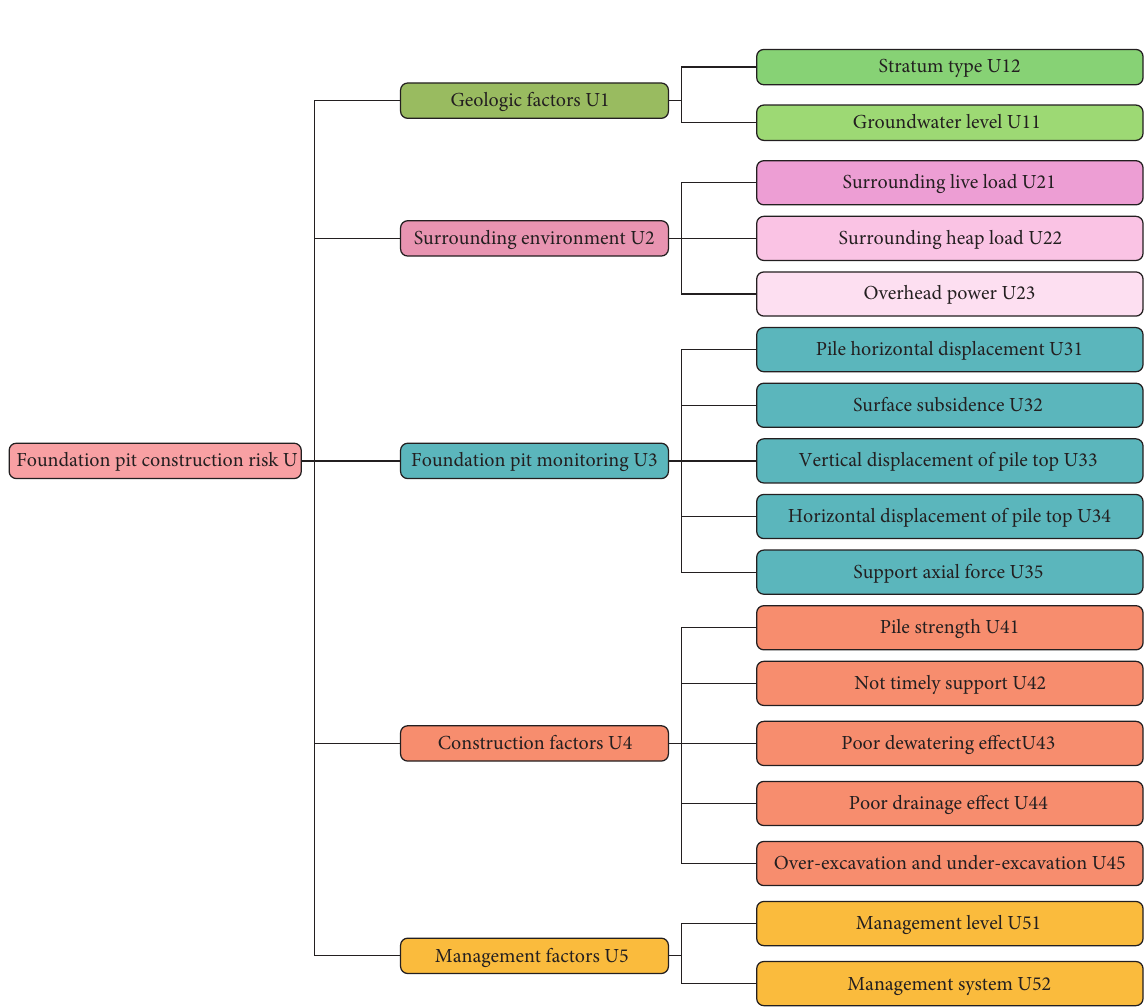
Figure 5: Risk assessment index system.